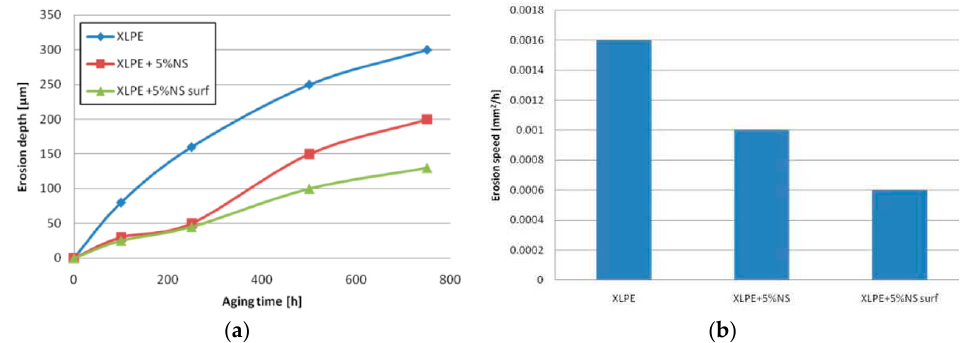
Figure 28. ( a ) Evolution of PD erosion depth with aging time of unfilled XLPE, XLPE with 5 wt % unfunctionalized nanoSiO 2 and XLPE with 5 wt % chemical agent functionalized nanoSiO 2 and ( b ) erosion speed for these kinds of XLPE (© 2016 IEEE. Reprinted, with permission, from [24]).